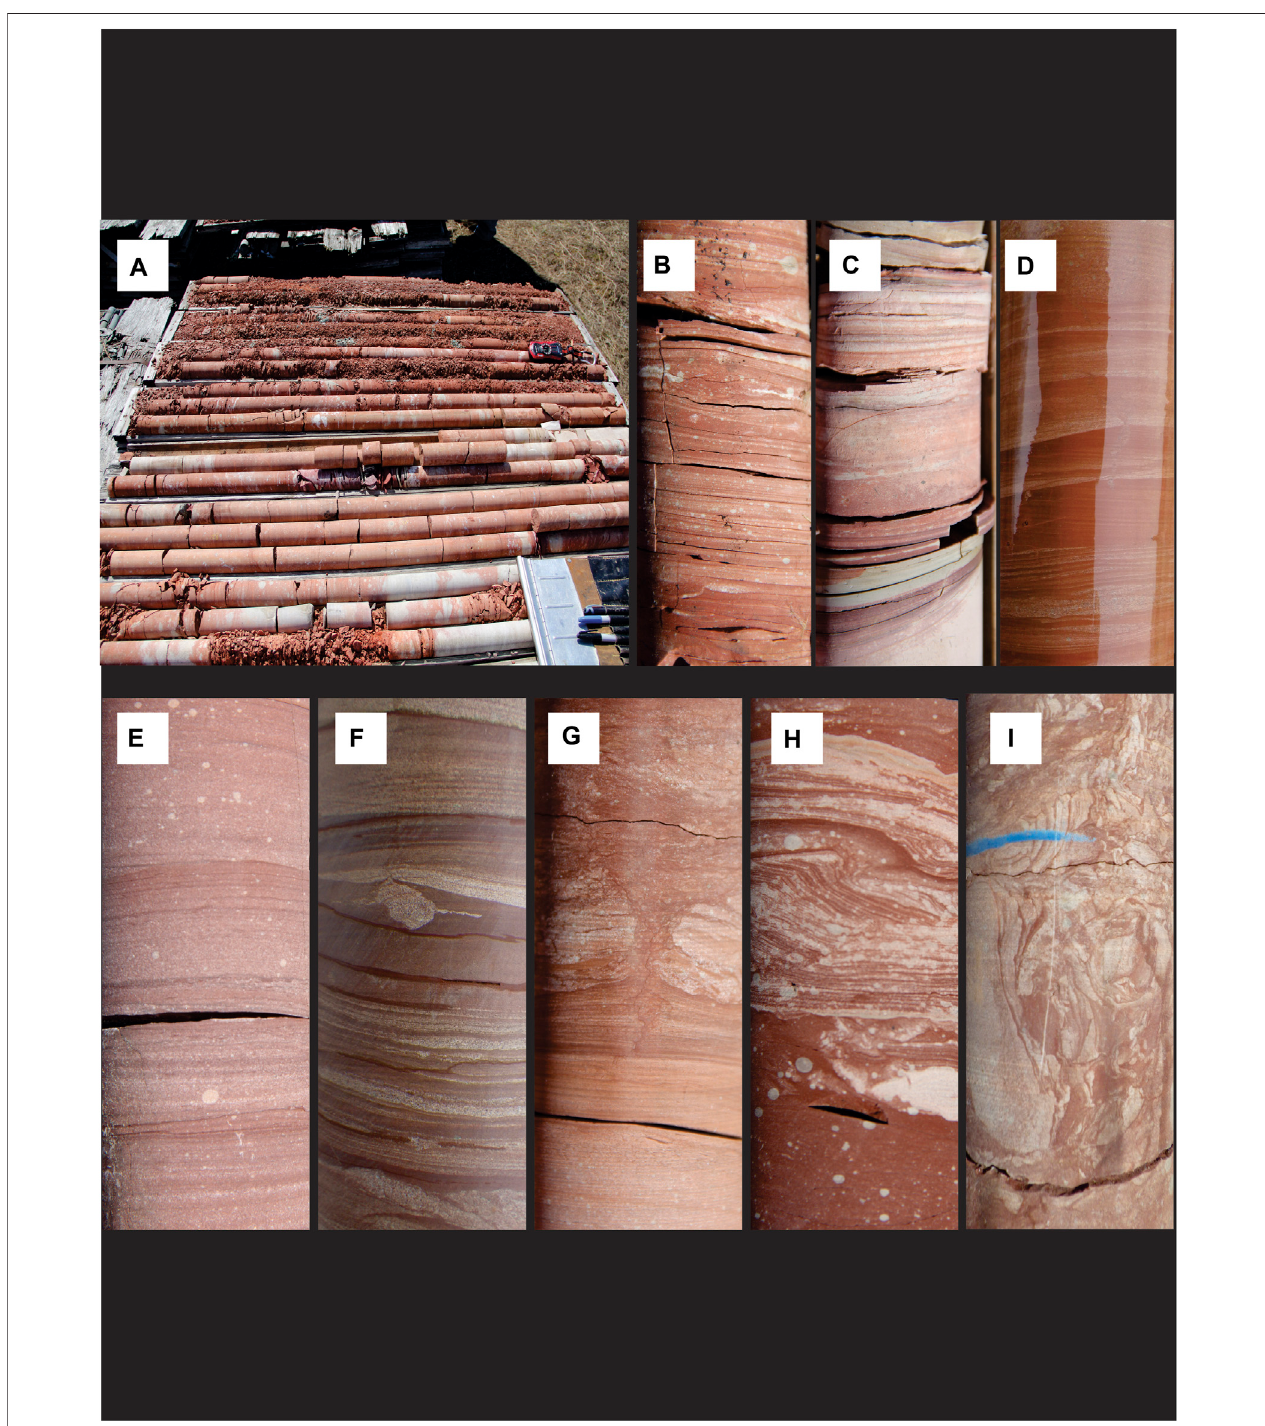
FIGURE 4 | Lithofacies that are common in the lower and middle portion of the lower coarsening- and thickening-upward succession and lower portion of the upper coarsening- and thickening-upward succession. Core is 4.5 cm wide. (A) Coarsening upward, 30 m thick, progradational parasequence with red mudstone dominating the lower portion (top of photograph), light red siltstone dominating the middle of the fi gure and siltstone plus white sandstone present in the top (bottom of photograph). (B) Layersofparallellaminatedclay-richandclay-poorsiltstone. (C) Parallellaminatedgreenmudstone;lightredsiltstone;andwhite,very fi ne-grained sandstone. (D , E) Massive layers grading from clay-poor to clay-rich siltstone. Light circular areas are reduction spots where the iron was diagenetically reduced by organiccarbon. (F) Massive,gradedlaminaewithminorloadingandsedimentinjection.Lensoidlayeringinbottomportionofthecore.Horizontallineswereproducedby drillchatter. (G) Dewateringinjection. Such features areverycommoninthe fi ne-grained sediment. (H) Contortedand disaggregated beddingproduced byshearstress generated during slumping. (I) Slump deposit consisting of disaggregated layers.